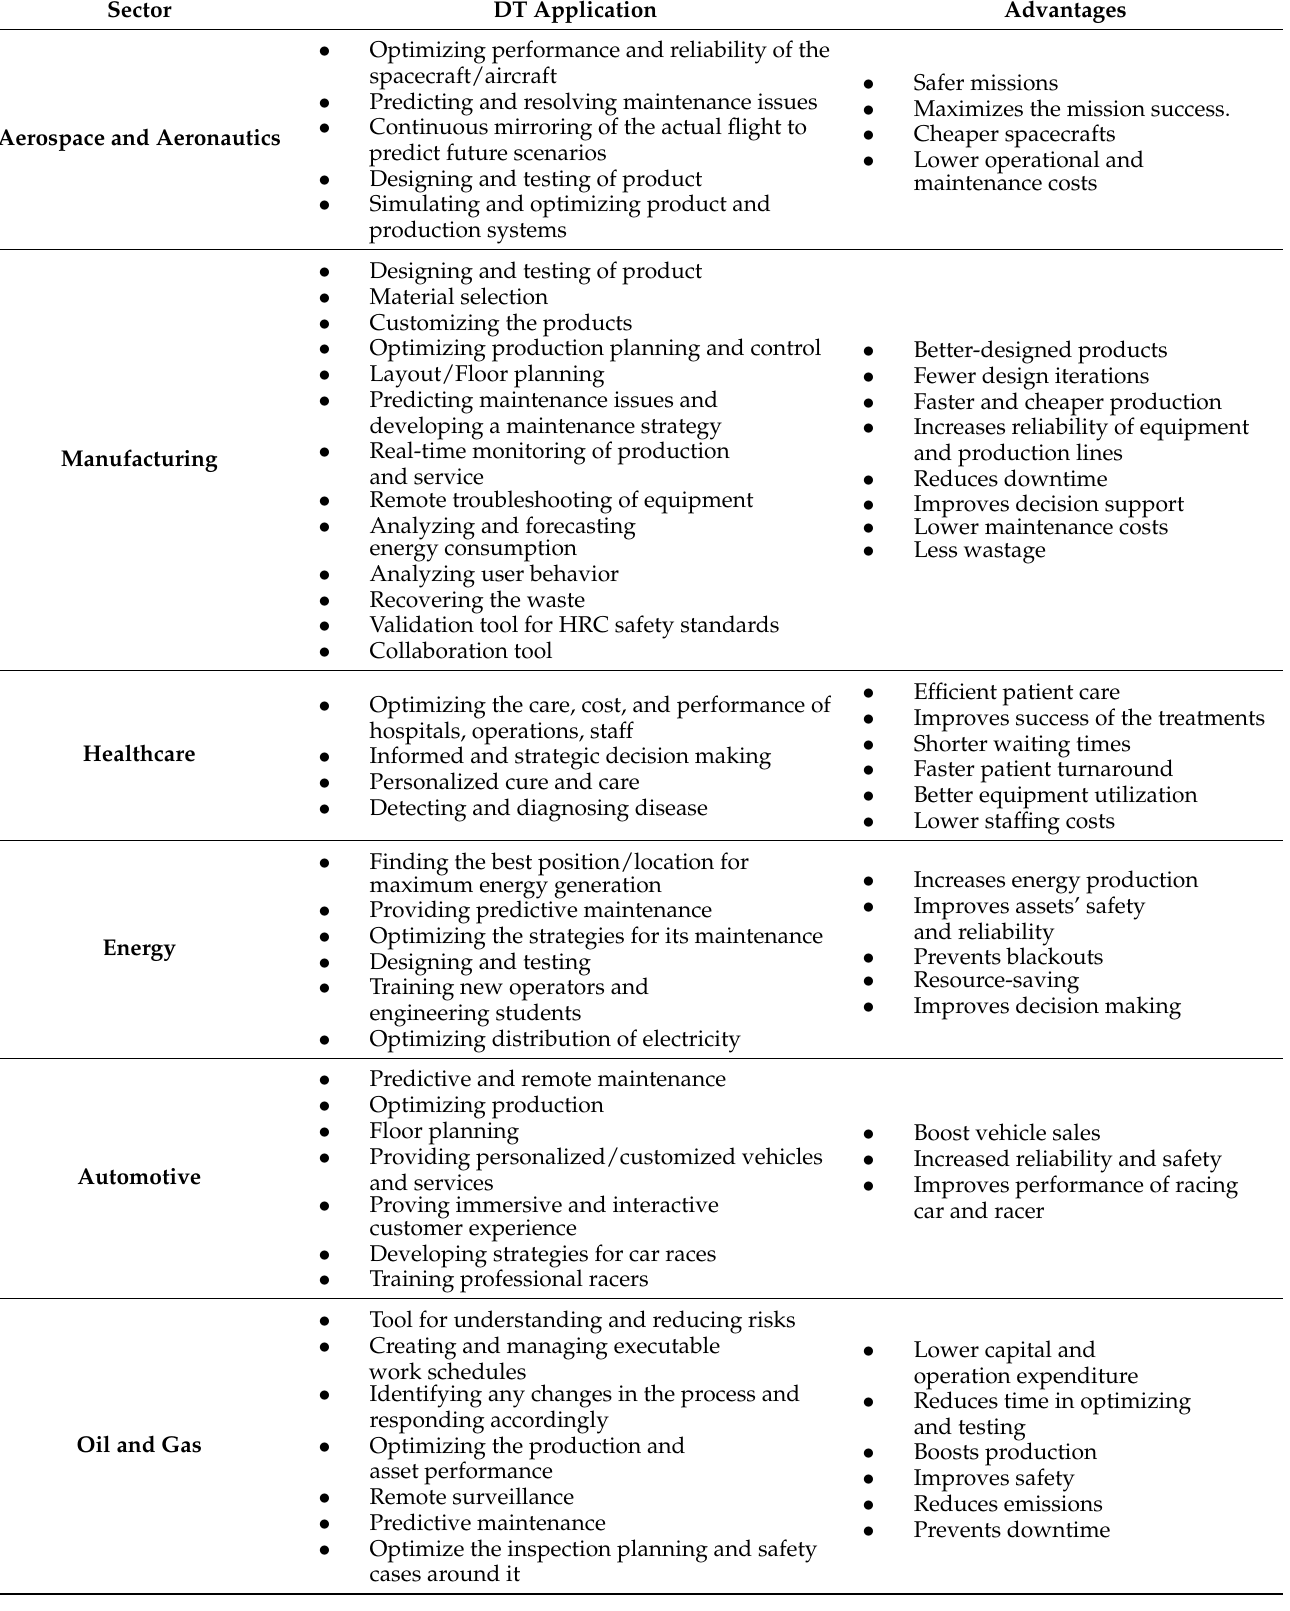
Table 3. Applications and advantages of DTs in different